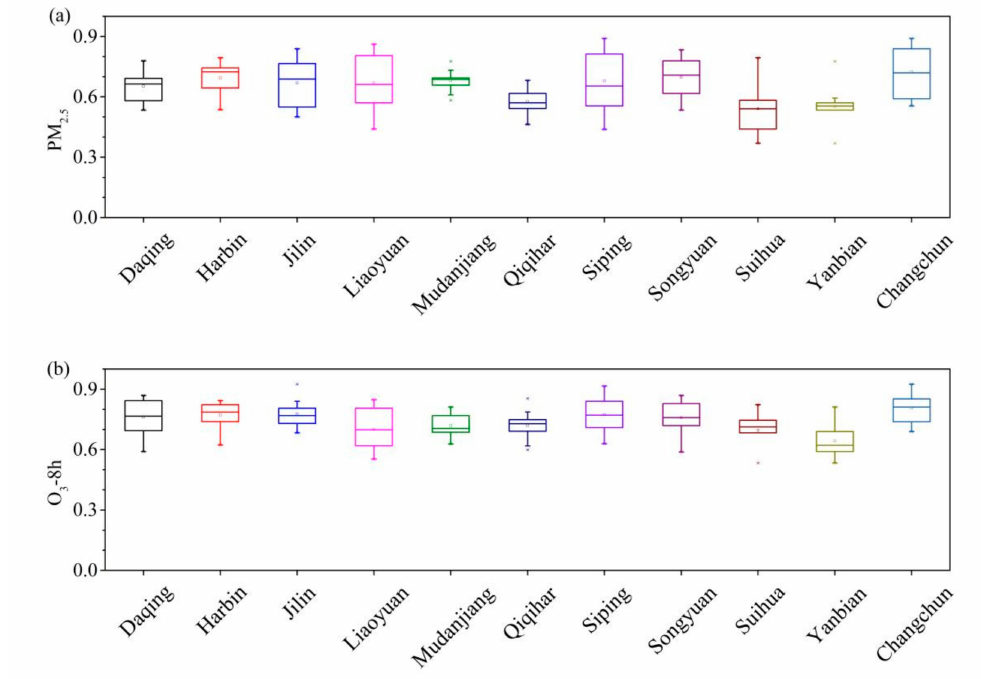
Figure 8. The box plot of Pearson correlation coefficient of ( a ) PM 2.5 and ( b ) O 3 -8 h. for each city with other cities in